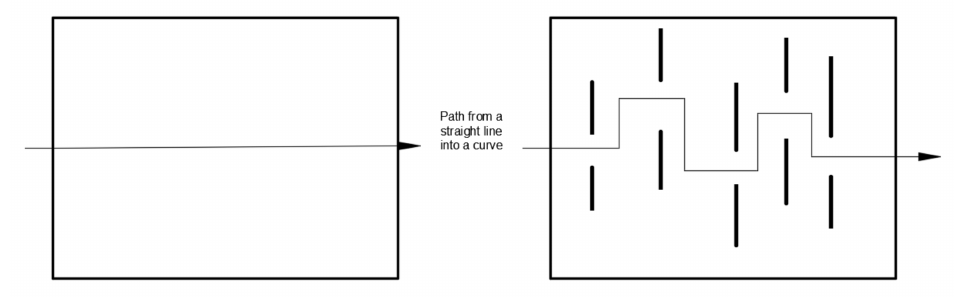
Figure 7. Nanoclay filler composite diffusion path schematic.